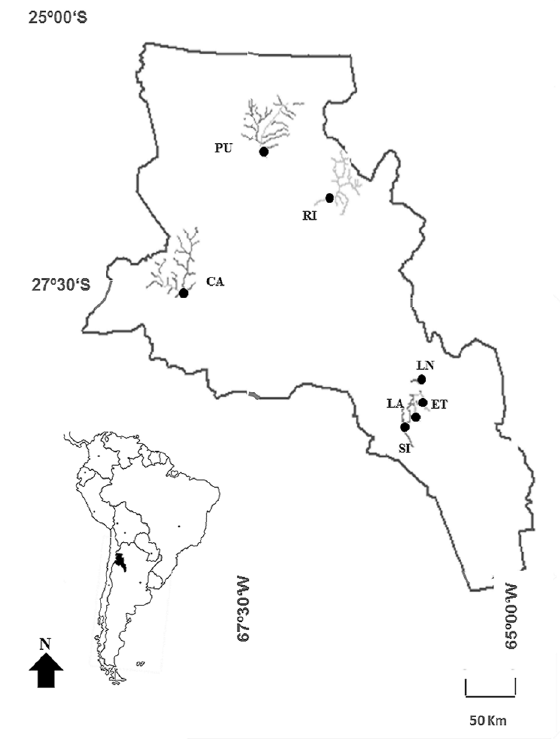
Figure 1. Location of Puna and Chaco Serrano streams, Catamarca,